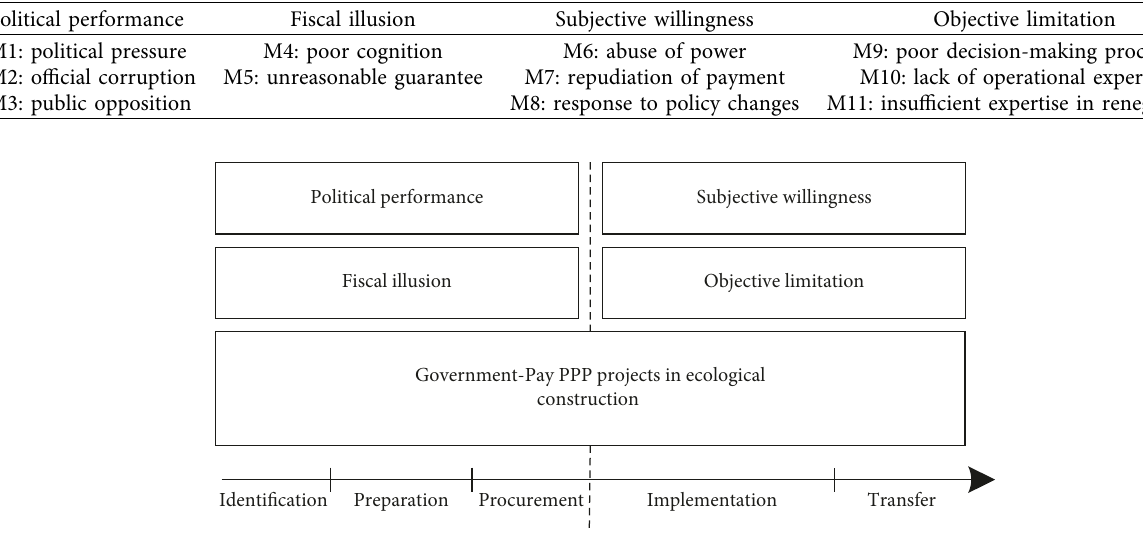
Figure 5: Distribution of each condition according to the processes of links.